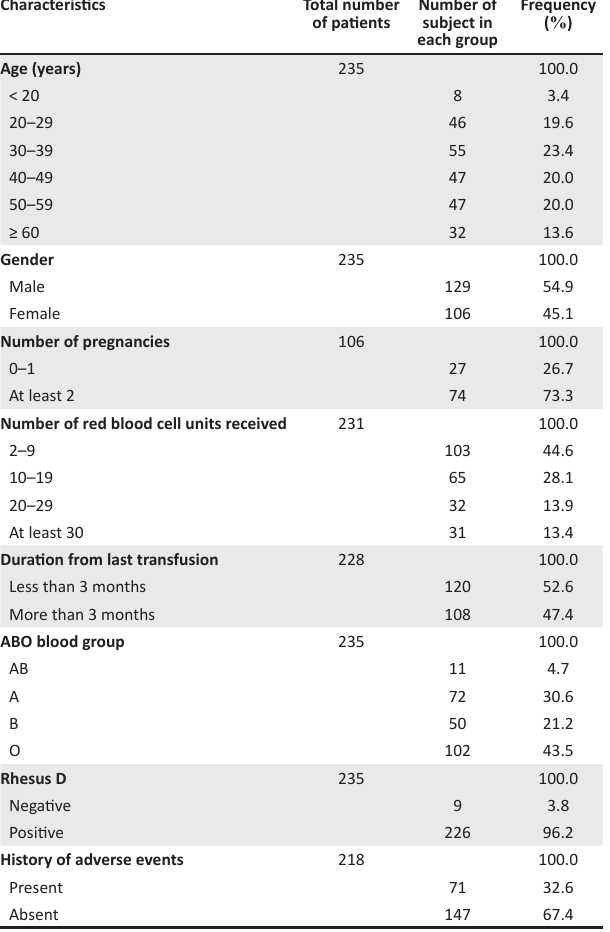
TABLE 3: Specificity and frequency of alloantibodies found among multi- transfused patients of the Yalgado Ouedraogo Teaching Hospital of Ouagadougou, Burkina Faso, 2018. † Type of Antibody